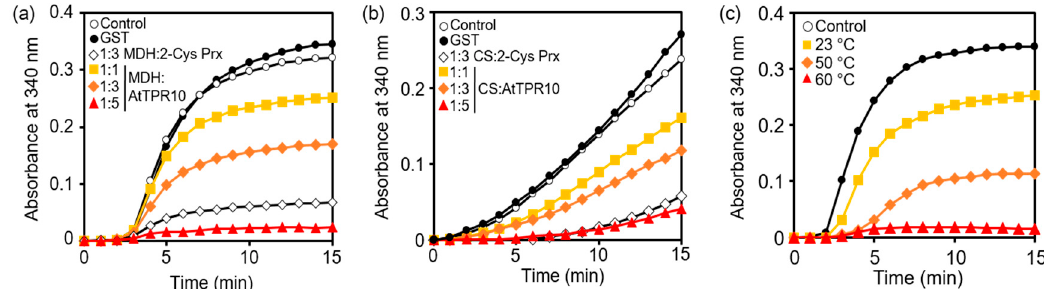
Figure 6. Chaperone activity analysis and heat shock-dependent activity regulation of AtTPR10. ( a ) and ( b ) Analysis of the chaperone function of AtTPR10 using MDH ( a ) and citrate synthase (CS) ( b ) as substrates. Thermal aggregation of MDH and CS was monitored at 340 nm after a 15 min incubation with AtTPR10. In ( a ), 1.5 μ M MDH was incubated at 43 °C, either alone ( ○ ; control) or with 7.5 μ M GST ( ● ), 4.5 μ M 2-Cys Prx ( ◇ ), and 1.5 μ M ( ■ ), 4.5 μ M ( ◆ ), and 7.5 μ M ( ▲ ) AtTPR10 in 50